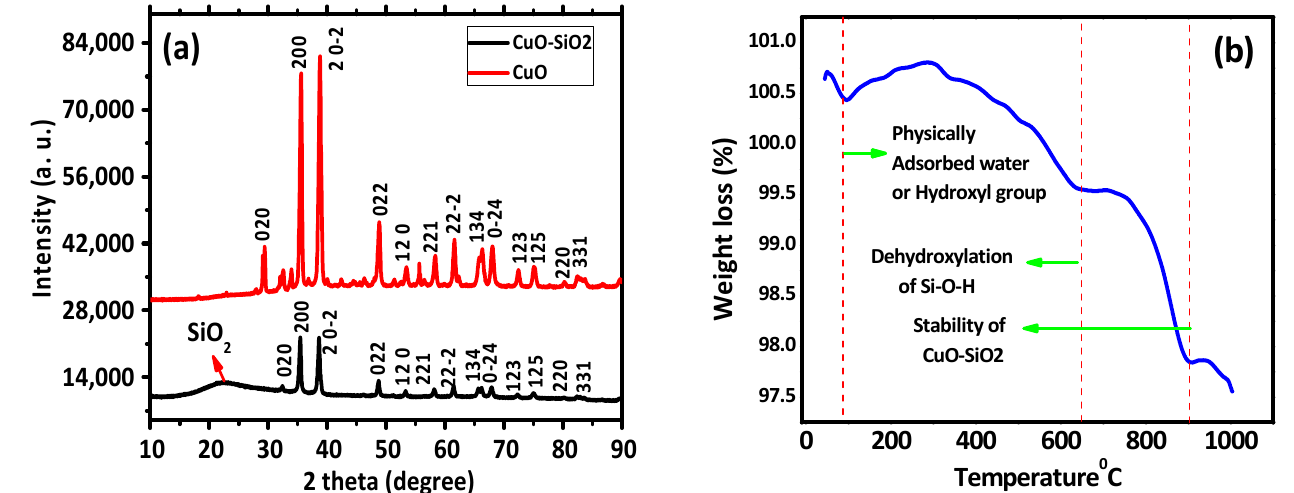
Figure 3. ( a ) XRD Spectra of CuO particles and the CuO–SiO 2 composite, and ( b ) TGA curve of the CuO–SiO 2